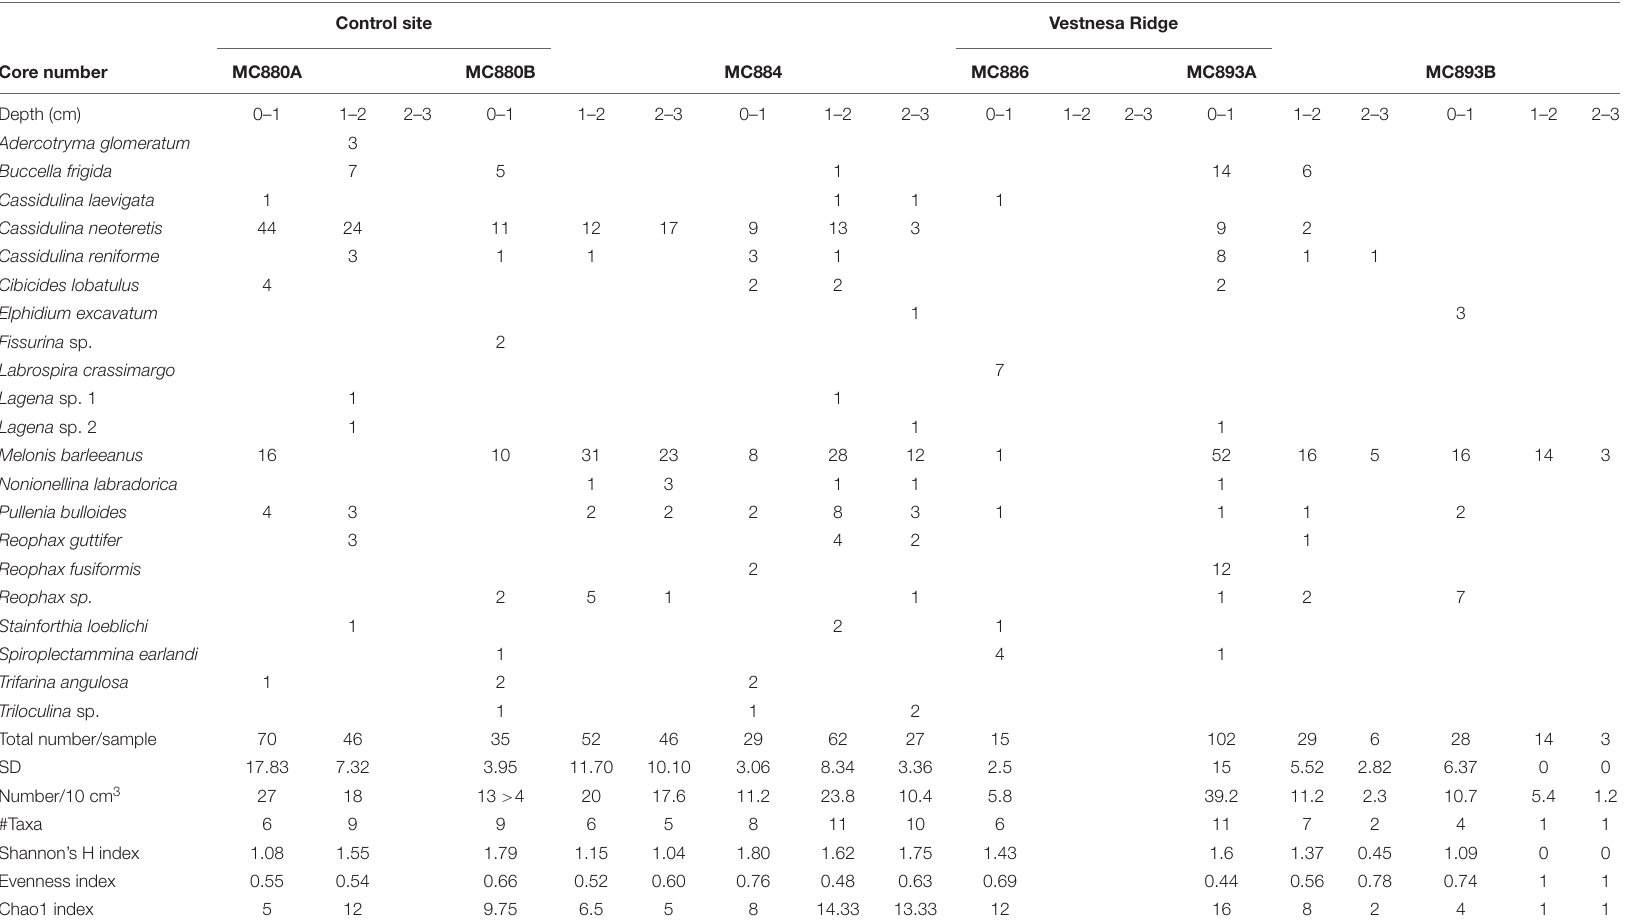
TABLE 3 | Direct counts of Rose Bengal stained foraminifera from all